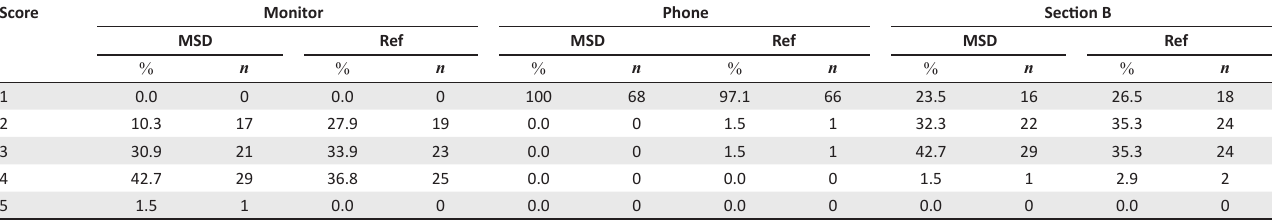
TABLE 6: Sub-scores of the rapid office strain assessment (Section B). Score Section B